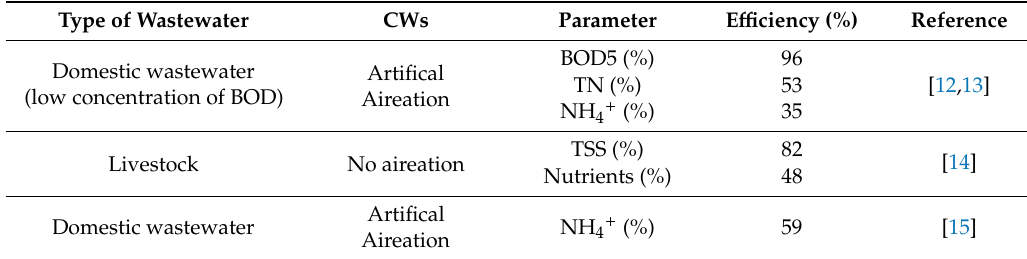
Table 6. Nutrient and organic matter removal e ffi ciencies achieved in constructed wetlands (CWs) depuration